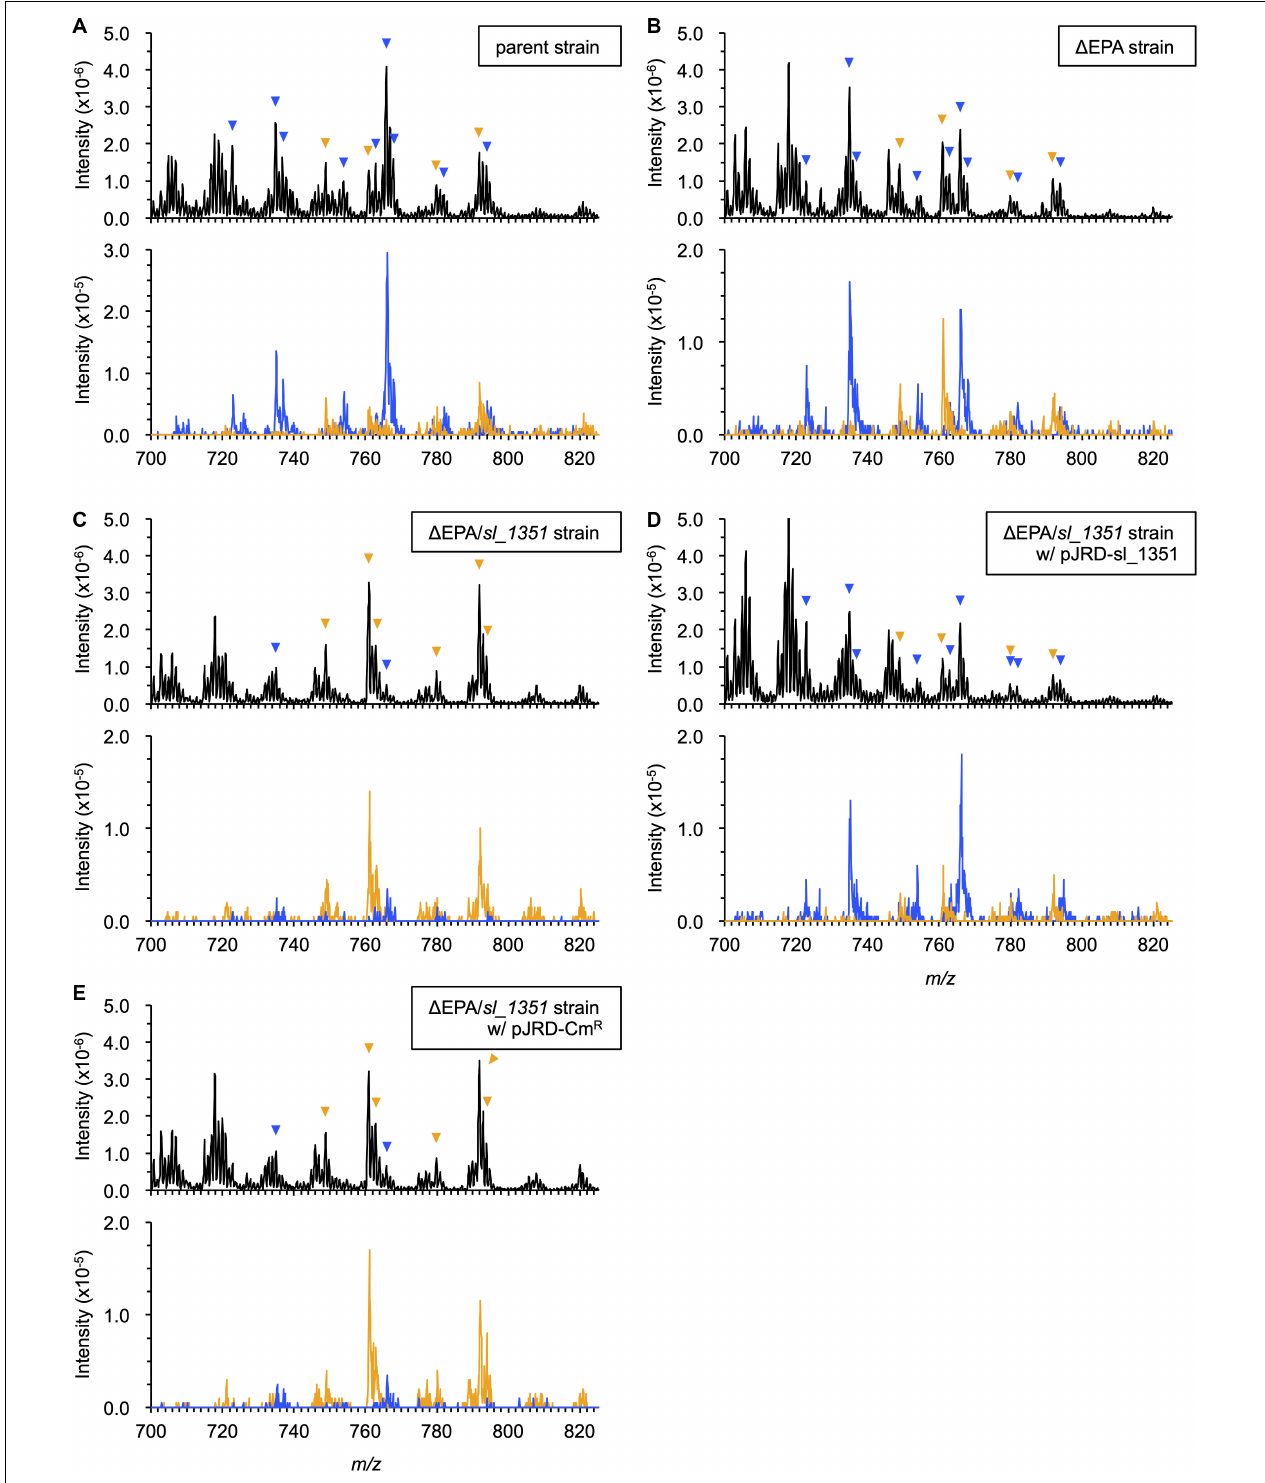
FIGURE 1 | ESI-MS analyses of PL compositions. The PLs were extracted from the parent strain (A) , (cid:49) EPA strain (B) , (cid:49) EPA/ sl_1351 strain (C) , (cid:49) EPA/ sl_1351 strain harboring pJRD-sl_1351 (D) , and (cid:49) EPA/ sl_1351 strain harboring pJRD-Cm r (E) grown in the presence of DHA. Three spectra of total ions (upper panel) and precursor ions for m/z of 301.4 and 327.4 (blue and orange traces on lower panel, respectively) are shown. The arrowheads indicate EPA- (blue) and DHA-containing PL ions (orange), of which predicted fatty acyl compositions are shown in Table 2 .